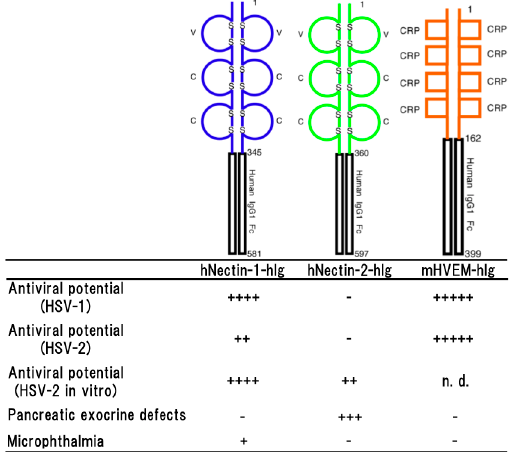
Figure 2. Schematic representation of a soluble form of human nectin-1 (hNectin-1-hIg), human nectin-2 (hNectin-2-hIg) and murine HVEM (mHVEM-hIg). Each fusion protein consists of each entire ectodomain and Fc portion of human IgG1 (upper part) and the properties of each transgenic mouse line (lower part). Antiviral potential against HSV-1 [33,44], HSV-2 in vivo [44] or in vitro [48] infection, pancreatic exocrine defects [48] and microphthalmia (unpublished data) as a side effect are shown. Numbers on the figure are shown amino acids number of each molecule. S represents disulfide bond. + to +++++ indicate relative strength of the phenotype. − means no phenotype observed.